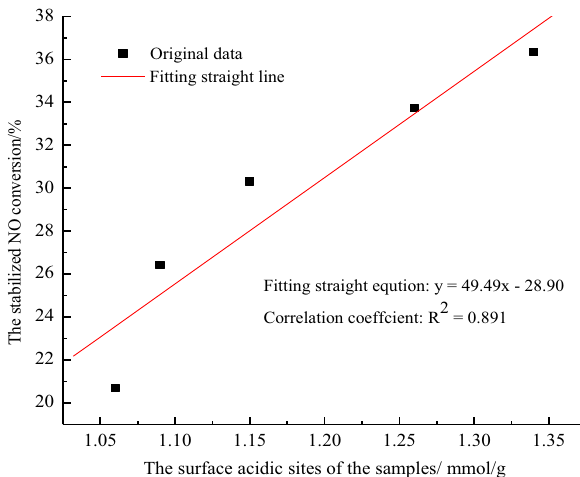
Fig. 6 Relationship between acidic sites and stabilized NO conversion